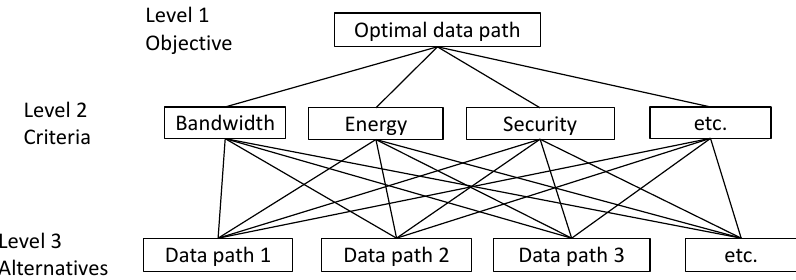
Figure 7. A hierarchical framework used for the AHP step.